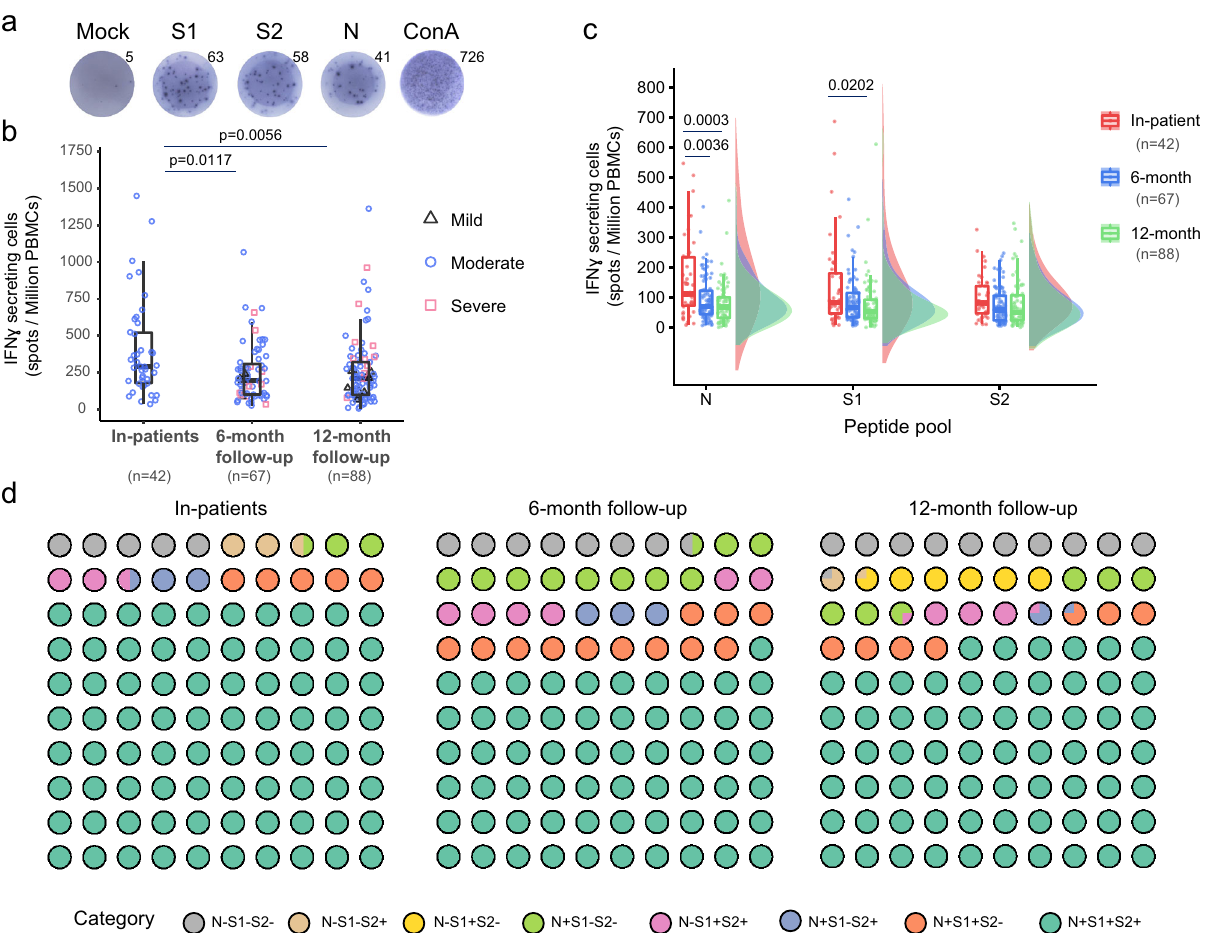
Fig. 3 SARS-CoV-2 speci fi c T cells response in recovered COVID-19 patients. a Representative ELISpot well images displaying IFN γ -secreting cells. N, S1, and S2, Synthetic overlapping peptide pool of nucleocapsid (N), Spike 1 subunit (S1), and 2 (S2). Con A, Concanavalin A positive control. b Spot numbers of IFN γ -secreting cells indicating the reduction in SARS-CoV-2 speci fi c immune response over time. The numbers are the sum of N, S1, S2-stimulated wells. Data were presented as median with interquartile range. c Raincloud plots show different T cellular response levels among three peptide pools at different time points of follow-up. d Waf fl e dot plot showing composition percentage of the SARS-CoV-2 response during 1-year follow-up. Statistics by Mann – Whitney U -test. P value (two-tailed) were shown. b , c Data were represented as box-and-whisker plots (median with interquartile, upper-limit, and lower-limit). Source data are provided as a Source Data fi